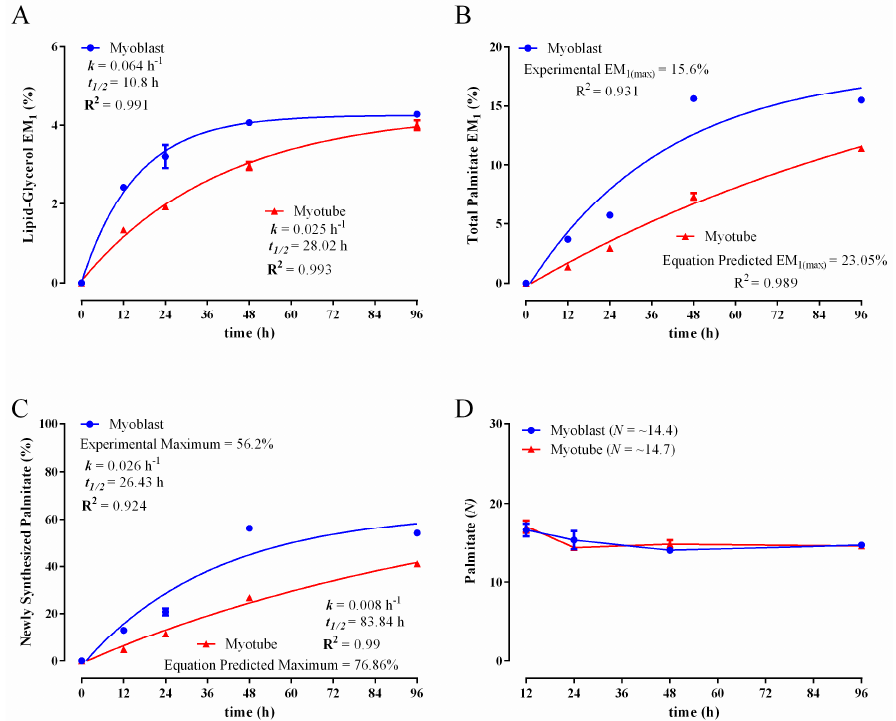
Figure 4. Comparison of 2 H-incorporation into lipid-derived glycerol and total palmitate in C2C12 myoblasts and myotubes following incubation in the presence of 4% 2 H 2 O. Excess molar enrichment in the M 1 isotopomer (EM 1 ) over time in lipid-derived glycerol ( A ) and total intracellular palmitate ( B ) in myoblasts and myotubes. Percentage of newly-synthesized palmitate in myoblasts and myotubes ( C ). The experimental maximum (plateau) value represents the percentage of the total intracellular palmitate pool that was de novo derived. For myotubes, given that plateau values were not experimentally achieved, this value was equation predicted. The maximum number of exchangeable carbon bound hydrogens ( N ) in palmitate as determined using mass isotopomer distribution analysis (MIDA) ( D ). Inset: fractional synthesis rate constant ( k ), half-life ( t 1/2 ) and goodness-of-fit (R 2 ) from non-linear curve fitting. N values seen in the brackets of the legend (D) are an average of those obtained at the 48- and 96-h time points; these exhibited the greatest amount of labelling and, therefore, permit the most accurate calculation of N using MIDA. Two replicates were performed for each time point. Error bars represent the standard error of the mean